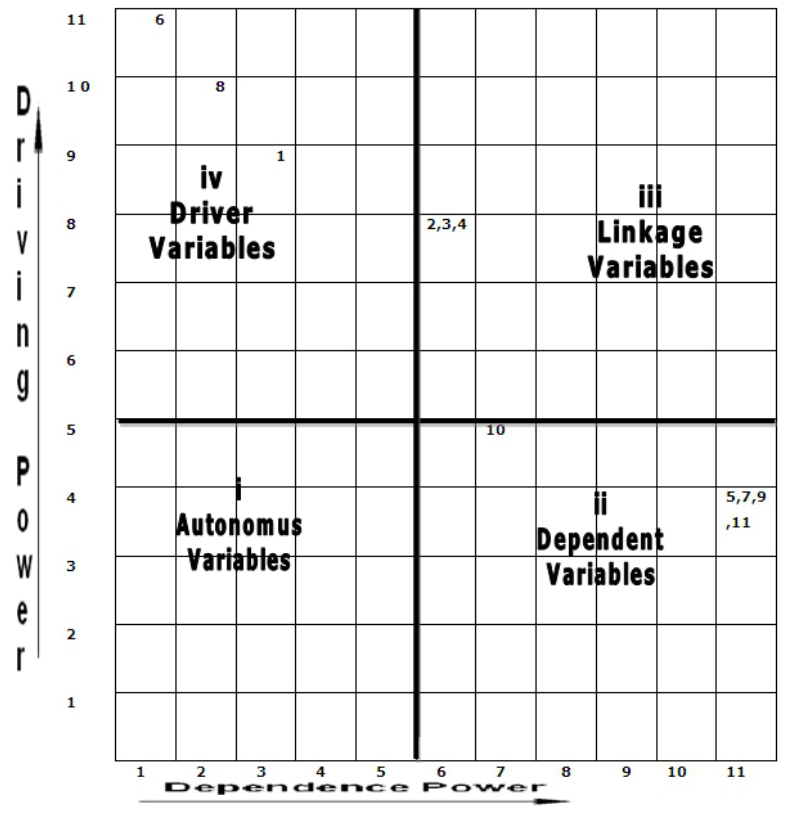
Figure 1. “Cluster of Barriers to Implement GSCM in Indian Automobile